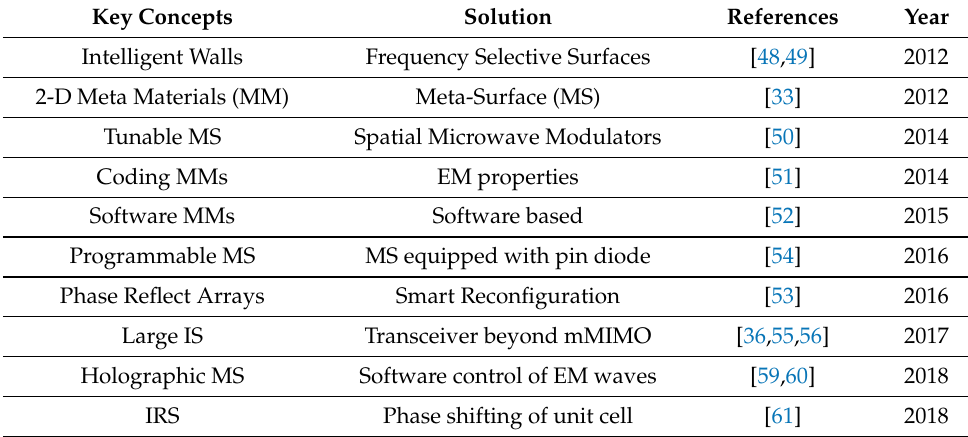
Table 1. Historical Perspective of